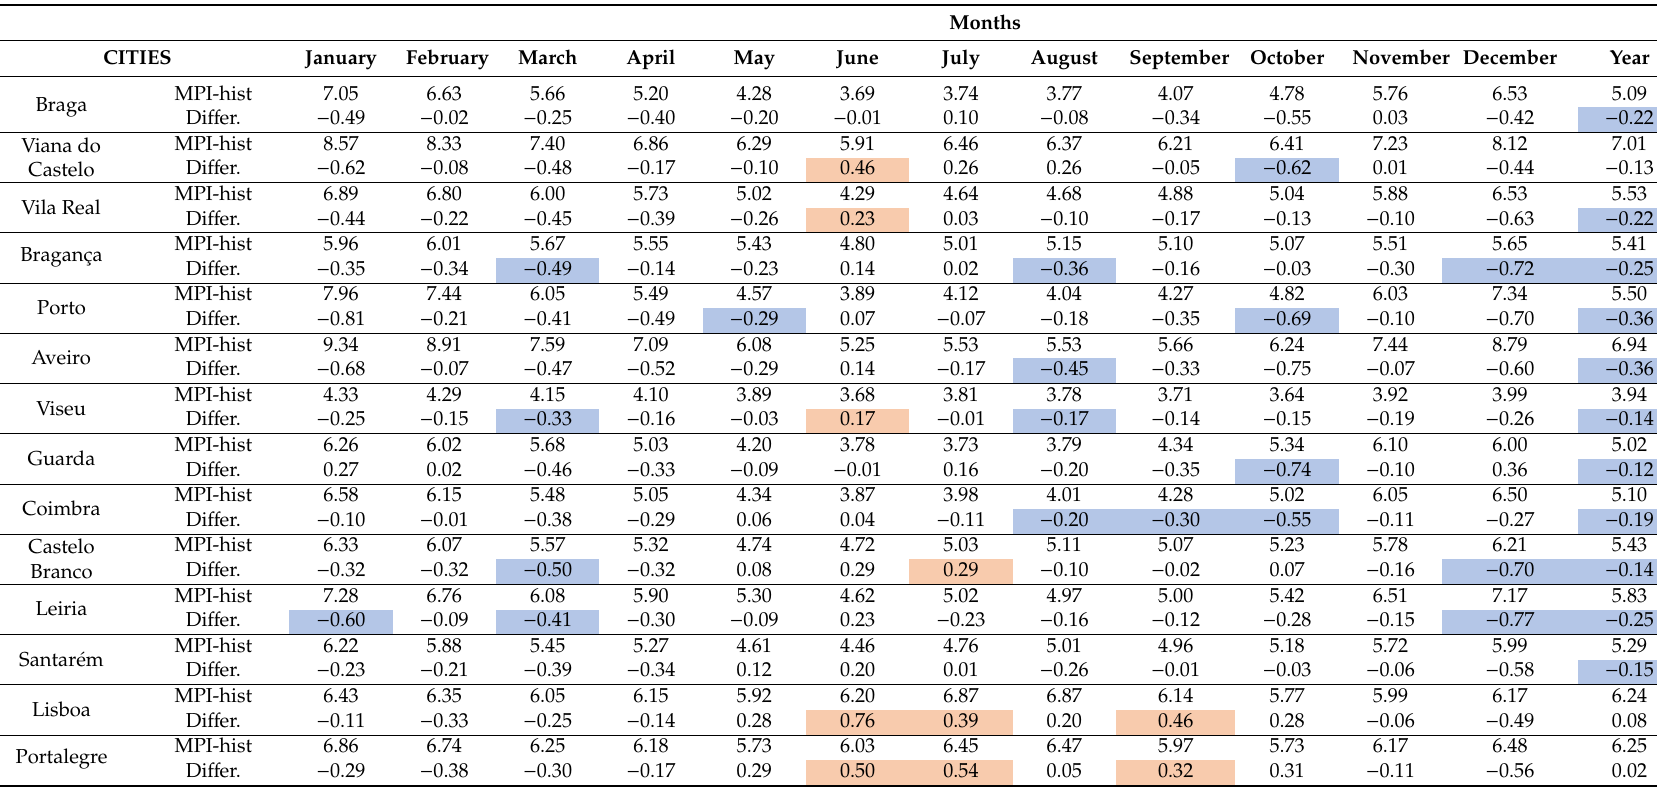
Table 5. Monthly and annual averaged wind speed near the surface for each city and the di ff erence between the future and the historical climates. Significant di ff erences ( t -student 5%) are shown in red (positive) and blue